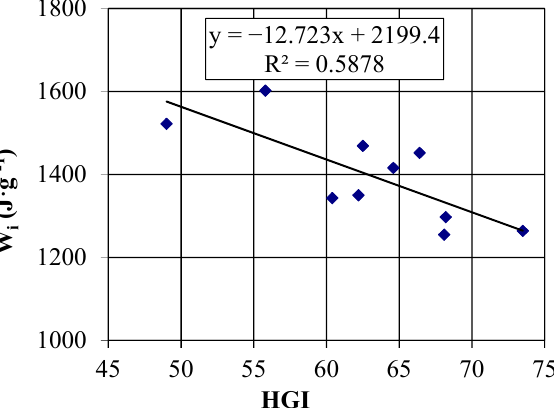
used to determine the wear resistance of various materials. The new method requires about three minutes for one test, which is less than it takes with the standard method.